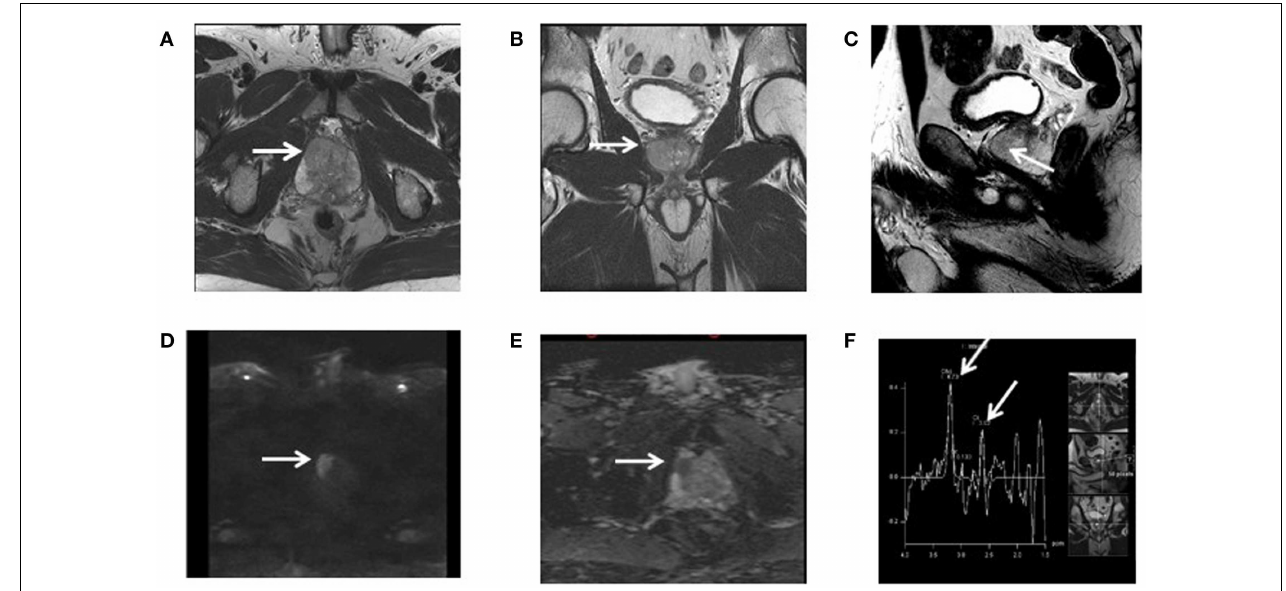
T2-weighted images. Axial diffusion weighted, b = 2000 (D) and ADC map (E) . 1H-spectroscopy demonstrating elevated choline/creatine-to-citrate ratio (F)